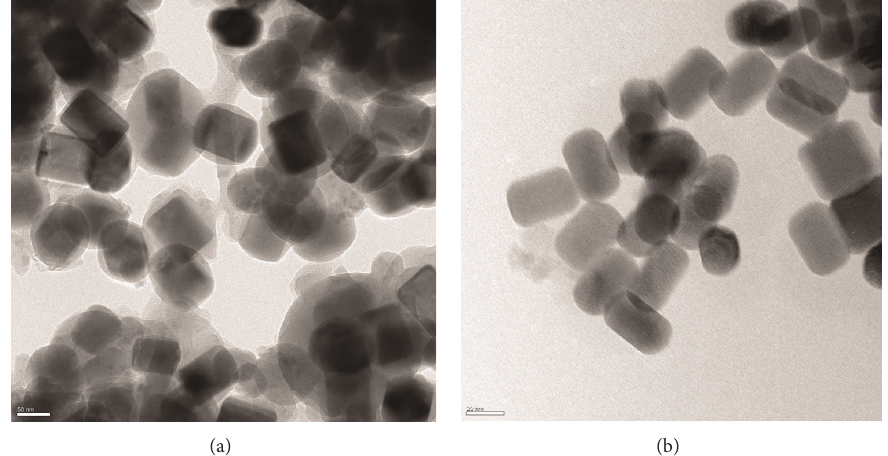
Figure5:TEMimageNaYF 4 :Yb 3+ ,Tm 3+ nanoparticleswithnominal12 nmthicksilicashell((a);scalebaris50 nm).TEMimageNaYF 4 :Yb 3+ , Ho 3+ nanoparticles with a thinner silica shell estimated to be 2 nm or less ((b); scale bar is 20 nm). In both cases, the silica shell includes the attached infrared dye, which is not discernible in the TEM